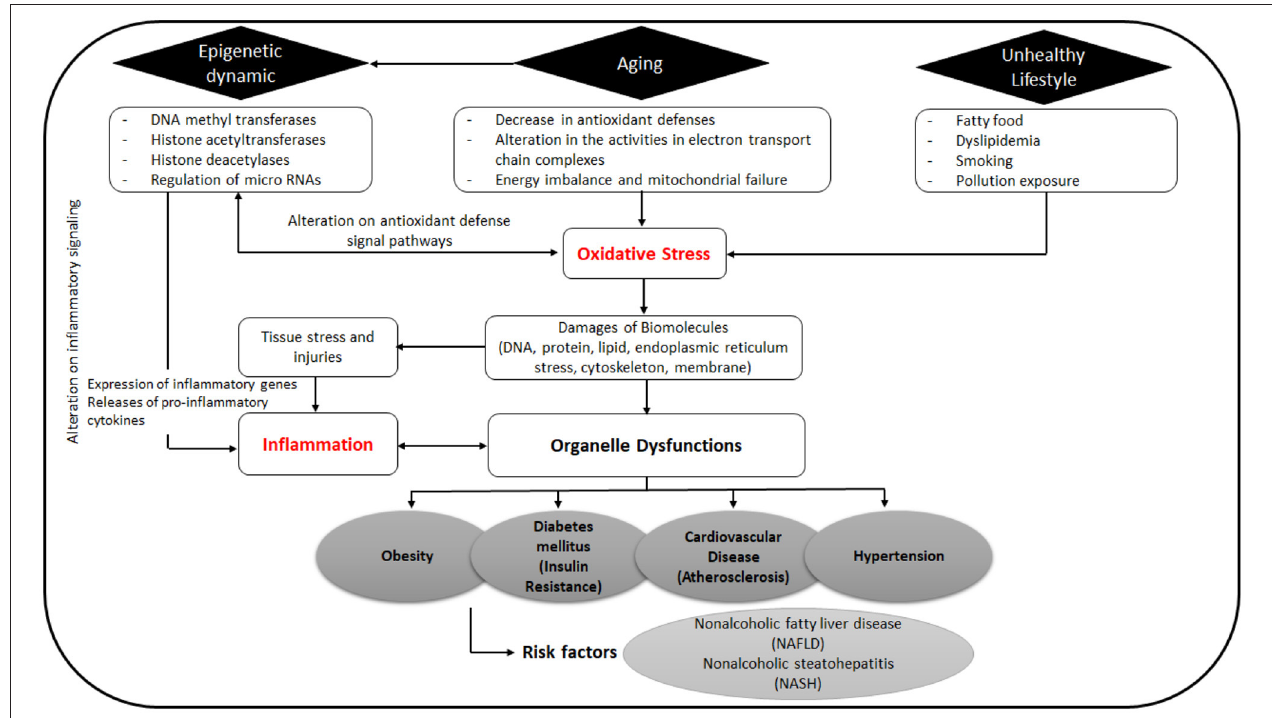
FIGURE 2 | Origin and pathology of oxidative stress and inflammation can lead to metabolic